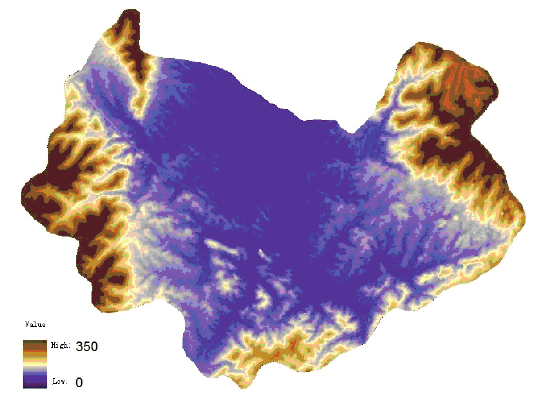
Fig. 1 DEM of Huashan Hydrological Experimental